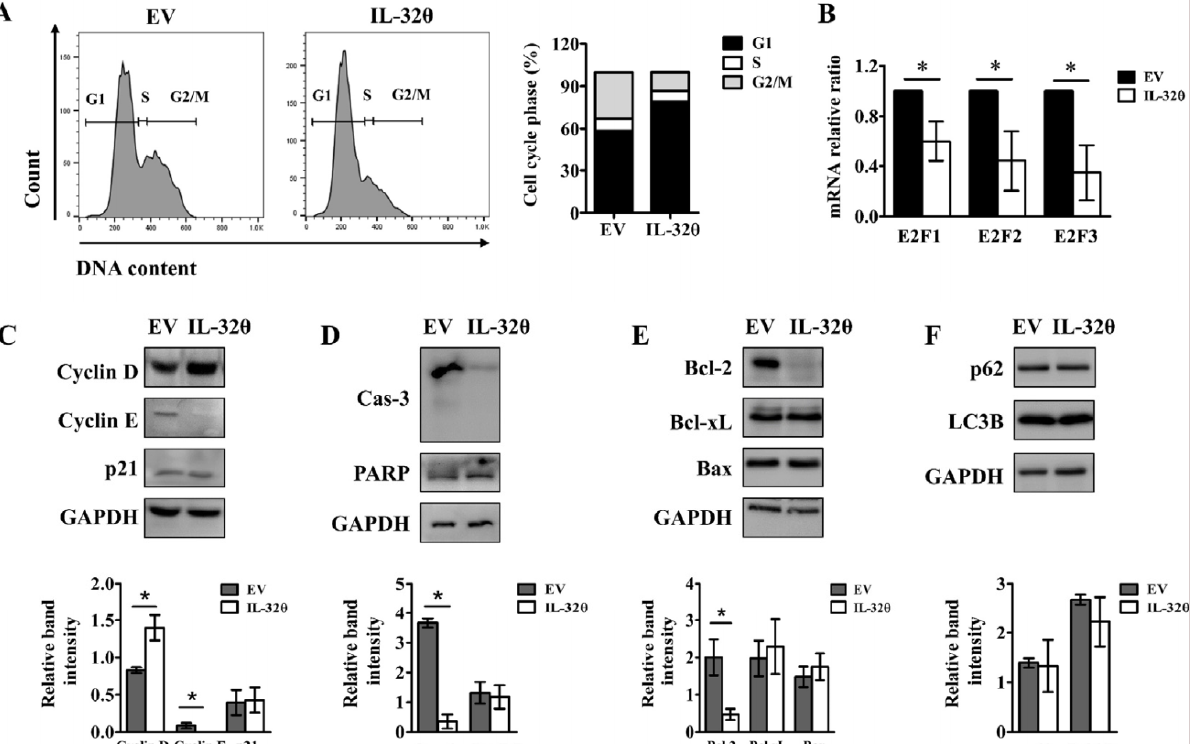
Figure 4. Effects of IL-32 θ on cell cycle progression, apoptosis, and autophagy. ( A ) Cell cycle profiles analyzed by staining cells with PI and flow cytometry. ( B ) Messenger RNA expression of E2F1, E2F2, and E2F3, measured by qPCR. ( C – F ) Western blots of cell cycle-regulated proteins (Cyclin D, Cyclin E, and p21), apoptosis markers (Caspase 3 and PARP), Bcl-2 family proteins (Bcl-2, Bcl-xL, and Bax), and autophagy markers (p62 and LC3B). Proteins were quantified using Fiji software. Intensity of proteins was normalized to that of GAPDH. * p < 0.05 (Student t -tests). Results are representative of three independent